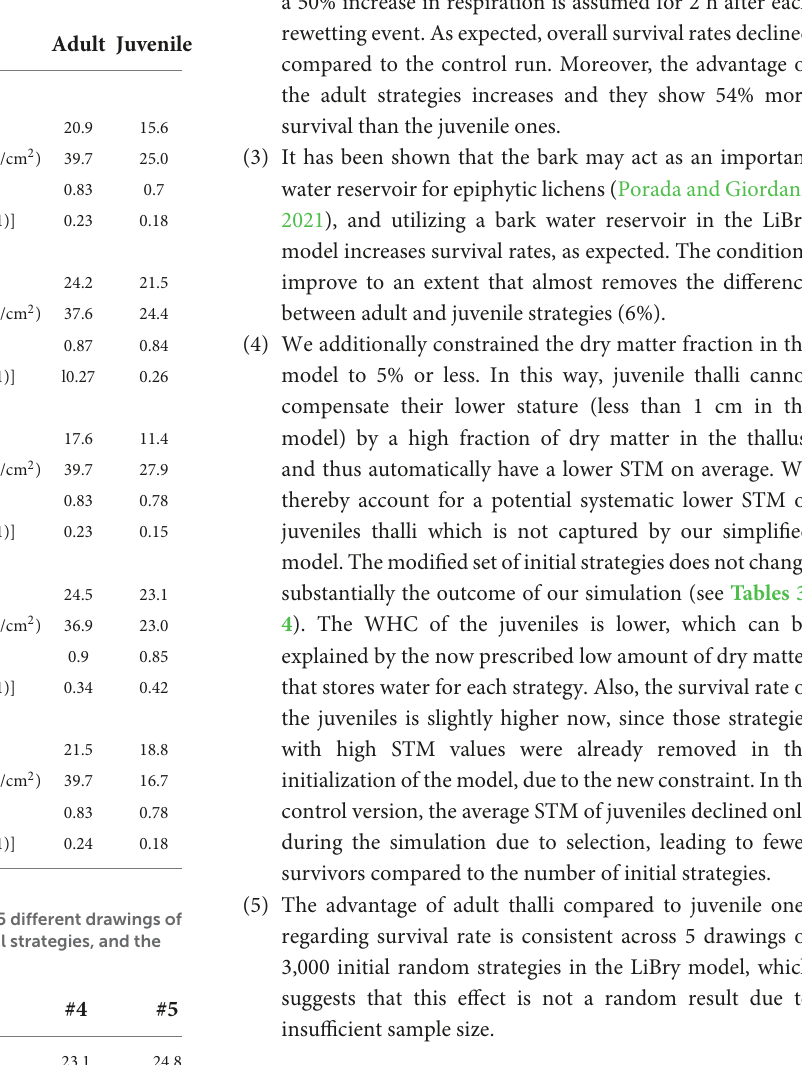
TABLE 3 Summary of sensitivity analysis.